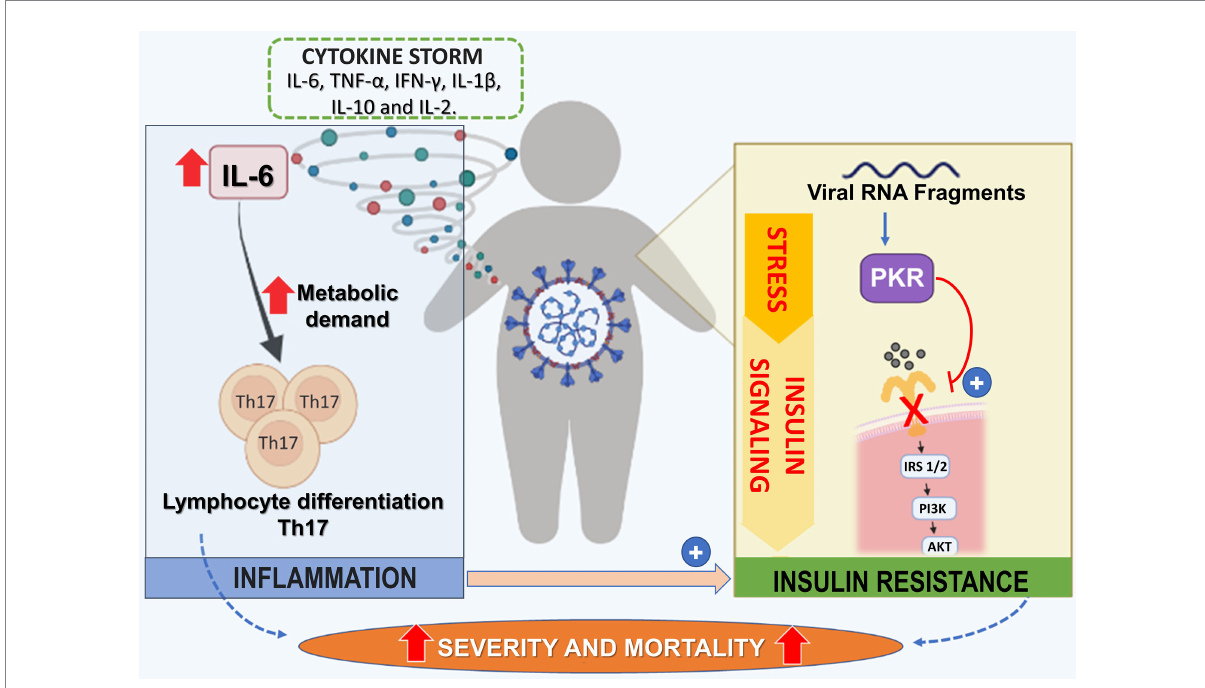
FIGURE 2 Potentiating Mechanisms of Virus Infection on Insulin Resistance State in Dm2 Patients. In patients with DM2 infected with COVID-19, there is an increase of cytokines, including IL-6, TNF- α , IFN-gamma, IL-1 β , IL-10, and IL-2 leading to cytokine storm. IL-6 is related to the differentiation of Th- 17 lymphocytes profile. This polarization process occurs with increased metabolic demand of lymphocytes, mainly through TCA and OXPHOS. On the other hand, the viral fragment of SARS-CoV-2 leads to activation of PKR (Protein kinase R), resulting in the serine phosphorylation of IRS-1/2, leading to the progression of insulin resistance. Together, cytokine storm and insulin resistance increase the risk of severity/mortality in individuals with DM2. TCA, citric acid cycle; OXPHOS, oxidative phosphorylation; PKR, Protein kinase